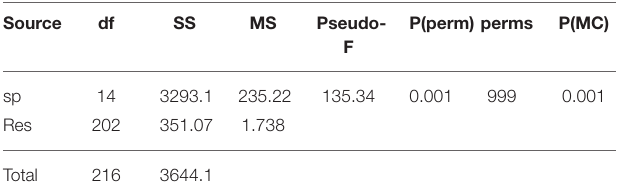
TABLE 5 | PERMANOVA main test result on nitrogen and carbon isotopes signatures for factor SPECIES.